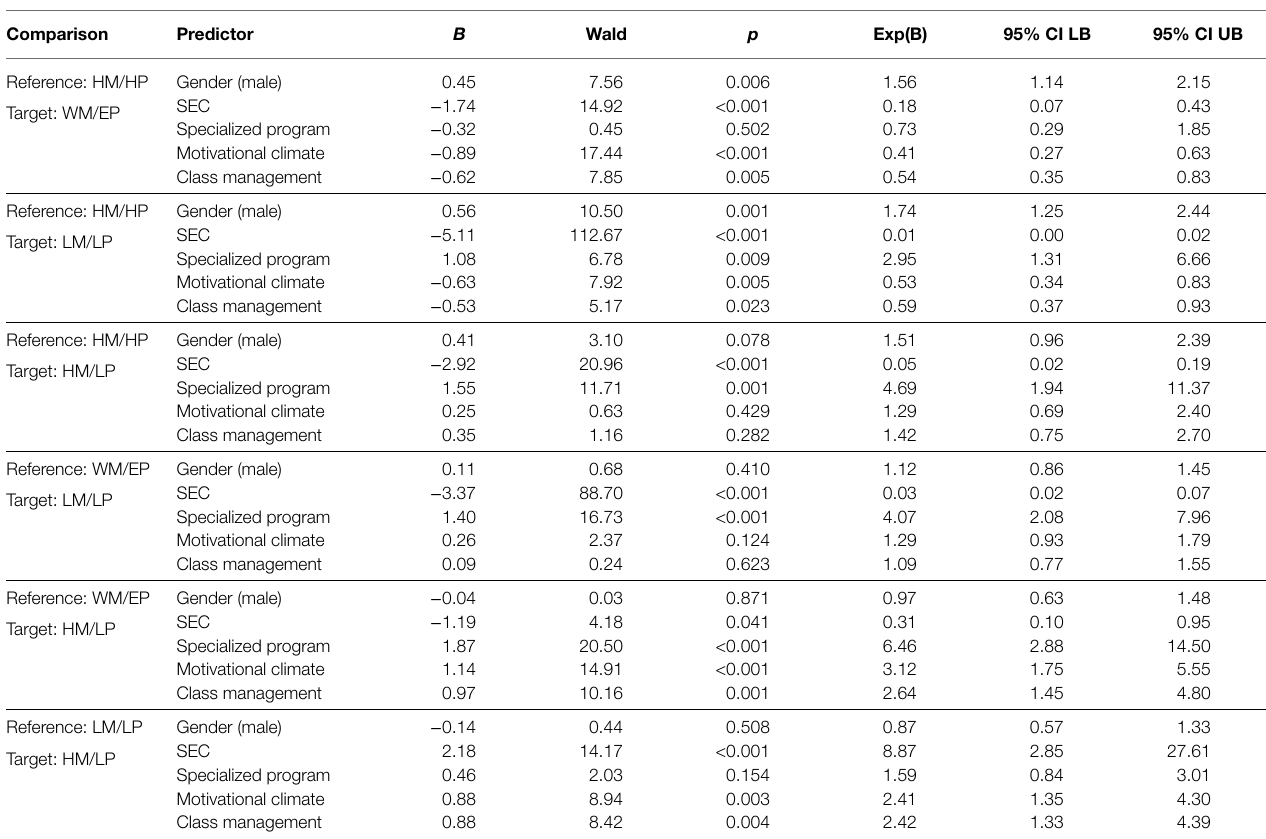
TABLE 3 | Multinomial logistic regression analysis results: parameter estimates for the final model. Comparison